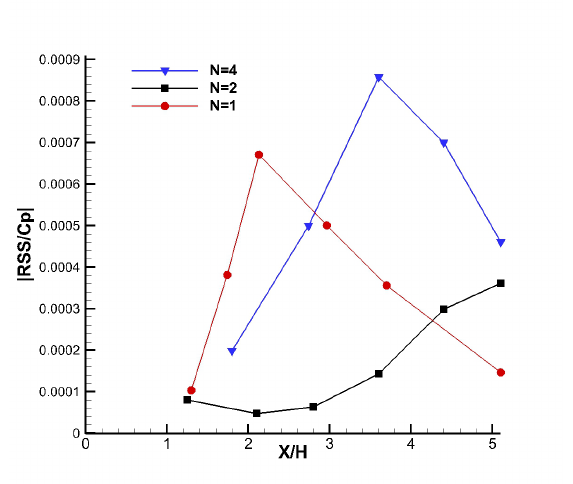
Figure 12. Ratio of streamwise turbulence intensity to pressure drop at Re = 3400. The downstream distance X is normalized by M ef f ( left ) and X peak ( right ).